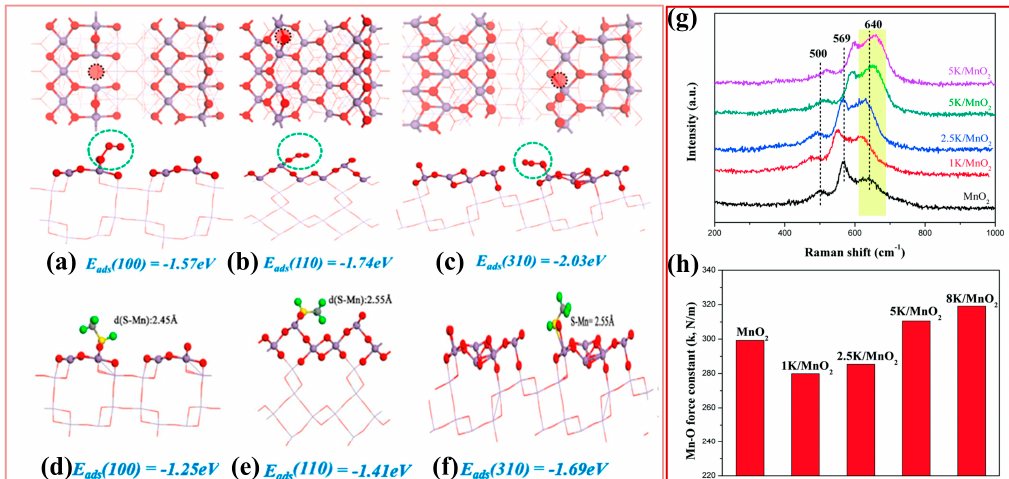
Figure 4. ( a – c ) Adsorption energy of O 3 on oxygen vacancy of α -MnO 2 with different exposed facets; ( d – f ) adsorption energy of S atom in CH 3 SH on oxygen vacancy of α -MnO 2 with different exposed facets. Reprinted with permission: American Chemical Society 2020 [81]; ( g ) Raman spectra of the different MnO 2 catalysts; ( h ) Mn–O bond force constant of various MnO 2 catalysts. Reprinted with permission: Royal Society of Chemistry, 2018 [91].